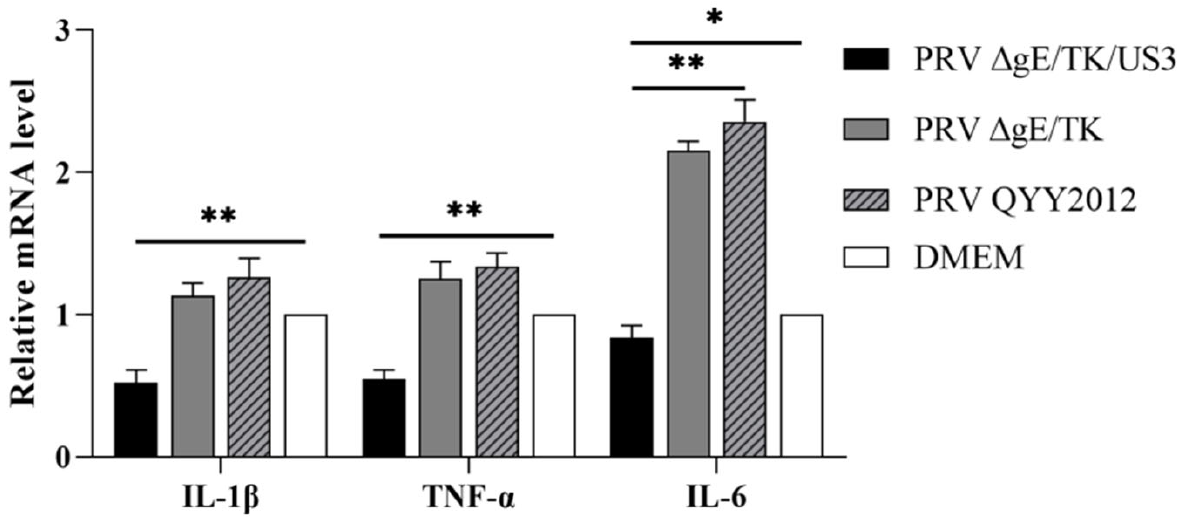
Figure 6. The expression level of pro-inflammatory cytokines in mice brain tissues inoculated with different PRV strains. At 48 h after inoculation, RNA in mice brain tissues was extracted and detected by RT-qPCR using primers of IL-1 β , TNF- α , and IL-6. Data was presented as mean ± SD.* p < 0.05, ** p < 0.01.